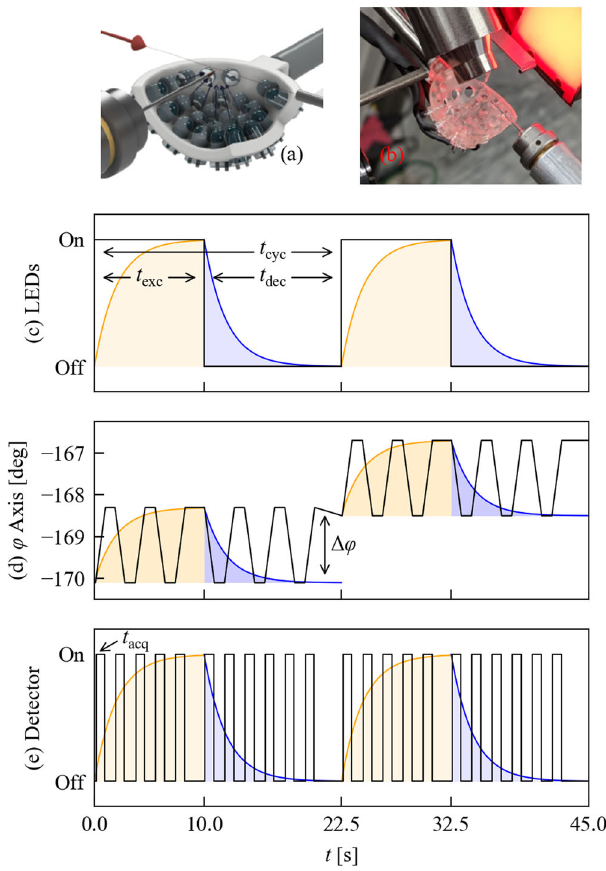
Fig. 1 Pump-probe SCXRD experiments using pulsed LEDs. a , b A CAD drawing ( a ) and photograph ( b ) of the 3D-printed LED holder in situ on the diffractometer. c , d Illustrate the data-collection procedure. The sample is subjected to repeated excitation/decay cycles of duration t cyc ( c ). The LEDs are activated for t exc to generate a photo-stationary excited-state (ES) population (yellow) and then switched off for t dec to allow the ES population to decay (blue). During each sequence the goniometer φ -axis is swept backward and forward through an angle range 4 φ ( d ) and the detector is electronically gated to record a series of data frames over a time interval t φ sweep are incremented after each acq ( e ). The start and end points of the sequence, thereby obtaining a time series of complete φ scans sampling the excitation/decay curve with a resolution t acq . The process is repeated to collect φ scans with the other goniometer axes in different positions to build up a full single-crystal dataset.